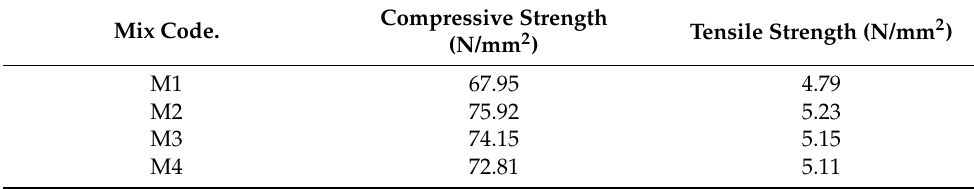
Table 3. Mechanical properties of the concrete specimens with different mixtures.